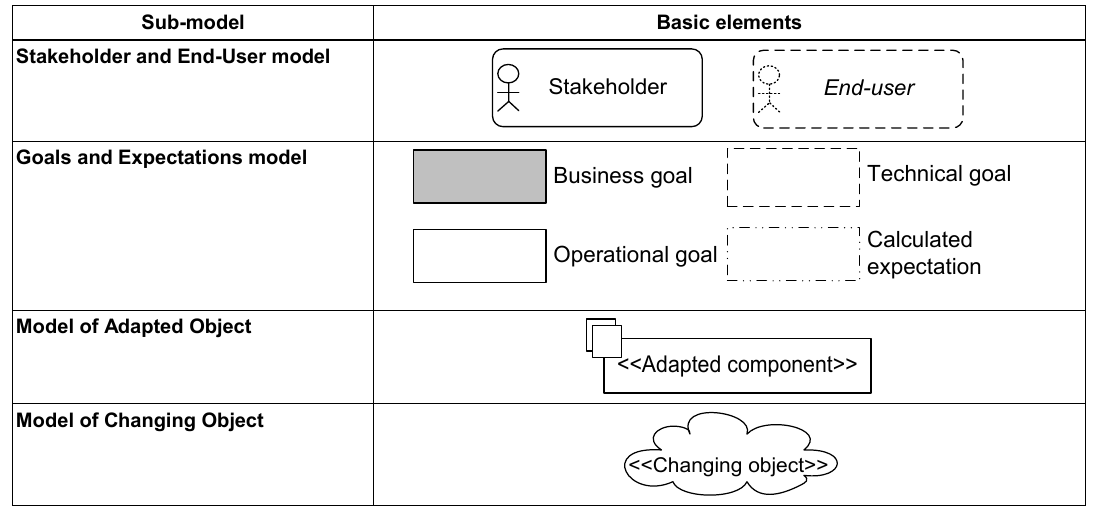
Table 1. Sub-models and their basic